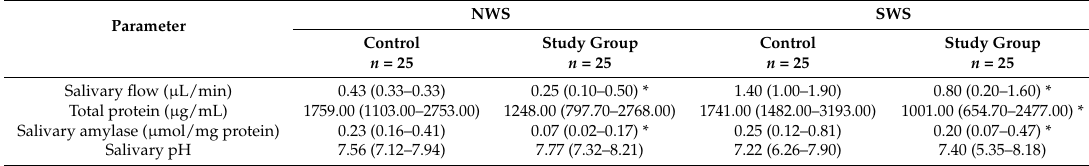
Table 3. Non-stimulated and stimulated salivary flow, total protein, amylase and pH.